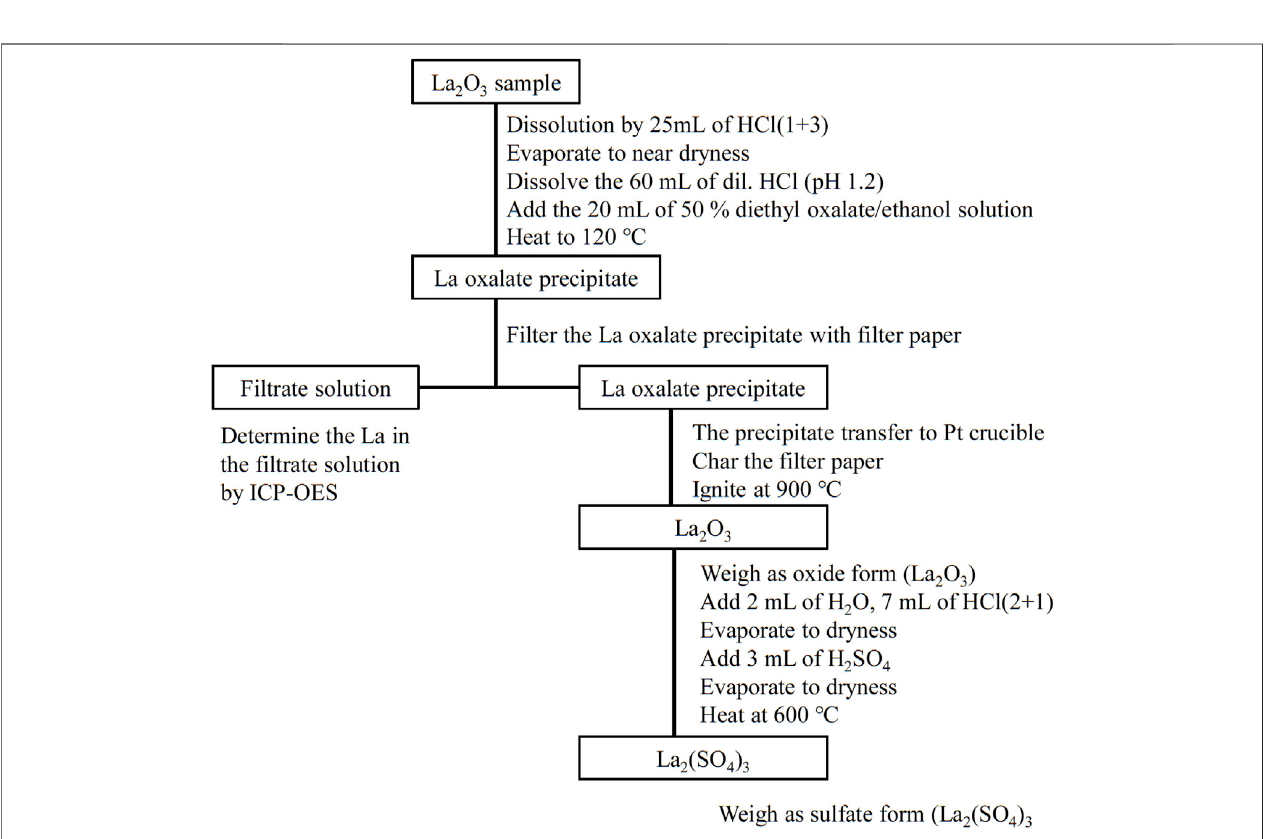
FIGURE 1 | Schematic diagram of the gravimetric analysis procedure for La.